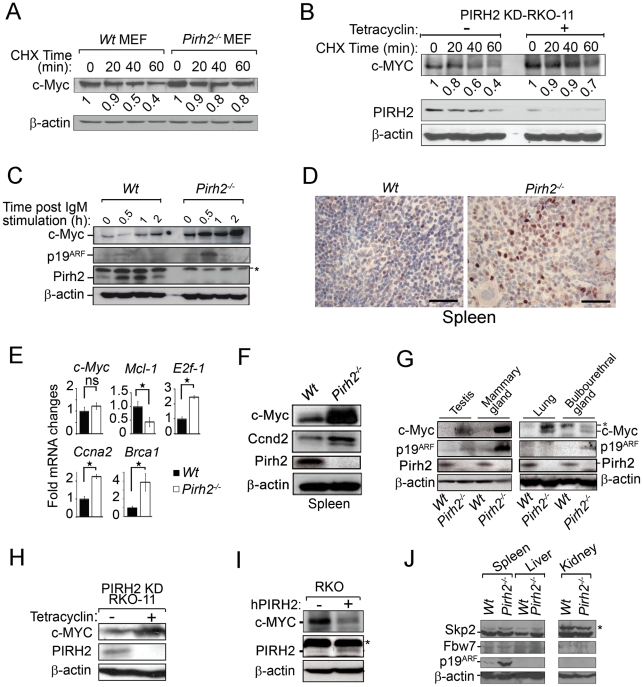
Increased c-Myc Protein Level in Pirh2 Mutant Cells and Mice.(A) Half-life determination of c-Myc protein in the presence or absence of Pirh2. Wt and Pirh2−/− MEFs were deprived of serum for 48 h, stimulated by re-exposure to serum for 4 h, and then incubated in the presence of CHX for the indicated times. Cell lysates were subjected to immunoblot analysis with antibodies for c-Myc or β-actin. c-Myc level was quantified based on scanning by densitometry using ImageJ and normalized by β-actin level. c-Myc fold increase is indicated. These data are representative of 2 independent experiments. (B) Half-life determination of the level of human c-MYC protein in the presence or absence of PIRH2. Tetracyclin inducible PIRH2 knockdown RKO cells (PIRH2 KD RKO-11) were grown in the absence or presence of tetracyclin for 72 h and CHX was added to these cells for the indicated times. Representative Western blot analysis of the effect of knockdown of PIRH2 on the expression level of c-MYC in RKO cells is shown. c-MYC level was quantified based on scanning by densitometry using ImageJ and normalized by β-actin level. c-Myc fold increase is indicated. (C) Immunoblot analysis of c-Myc, p19ARF and Pirh2 expression in splenocytes from 6 week-old Pirh2−/− and Wt littermates. Cell extracts were prepared at 0, 0.5, 1 and 2 h post anti-IgM stimulation. These data are representative of 4 independent experiments. (D) Sections from Wt and Pirh2−/− spleens were stained with anti-c-Myc antibody (Bar = 50 µm). (E) Quantitative real time PCR was performed to assess the mRNA level of c-Myc and its transcriptional targets E2f1, Ccna2, Brca1 and Mcl-1 in spleen from 10 to 13 month-old Wt (n = 4) and Pirh2−/− (n = 12) mice. mRNA expression was normalized to actin mRNA. Fold changes of mRNA expression is shown. Student's t test was used for statistical analysis. Stars indicate P<0.008; ns: not significant. Error bars represent SD. (F) Immunoblot analysis of c-Myc, Ccnd2 and Pirh2 expression in spleen from Pirh2−/− and Wt 10 month-old mice. (G) Immunoblot analysis of c-Myc, p19ARF and Pirh2 expression in testis, mammary glands, lung and bulbourethral glands from 8 week-old Pirh2−/− and Wt mice. *: non specific. (H) Western blot analysis of the expression of c-MYC in tetracyclin inducible PIRH2 knockdown RKO cells (PIRH2 KD RKO-11). Representative Western blots of three independent experiments are shown. (I) Western blot analysis of the effect on c-MYC level of transfected human PIRH2 (hPIRH2) in RKO cells. *: non specific. (J) Representative immunoblot analyses of the level of Skp2, Fbw7 and p19ARF in spleen, liver and kidney from 8 week-old Wt and Pirh2−/− mice. *: non specific.